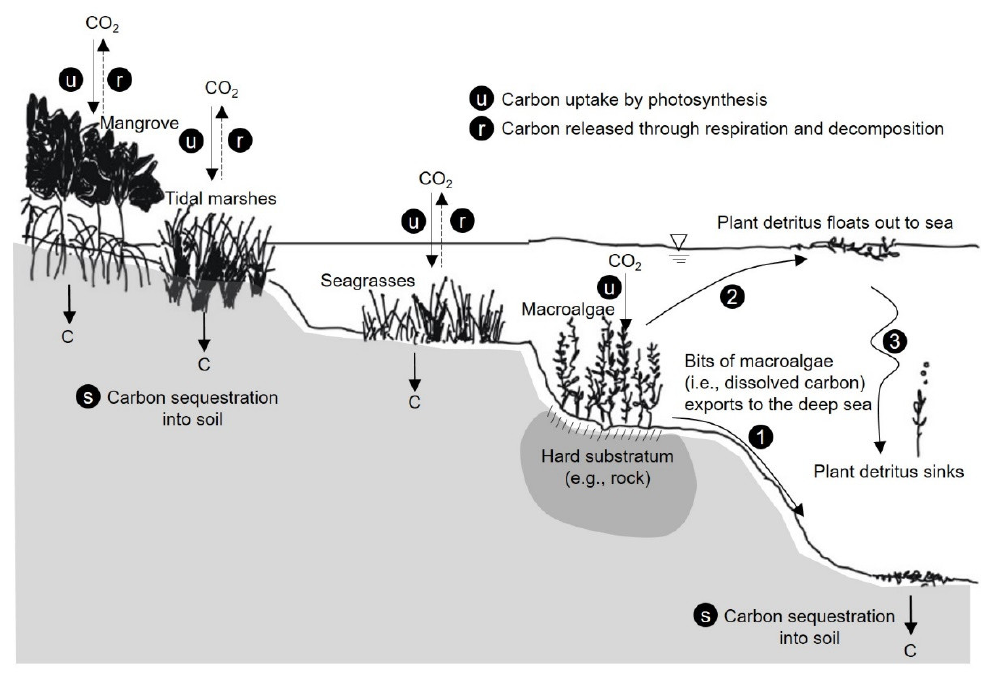
Figure 2. Carbon sequestration process by macroalgae and angiosperm-dominated ecosystems (e.g., mangroves, saltmarshes, and seagrasses). The angiosperm-dominated ecosystems uptake carbon by photosynthesis, release carbon through respiration and decomposition in the shore (often disturbed by natural and anthropogenic factors, e.g., runoff, human activity, and storms), and sequester the rest of the carbon into soil [21,23]. In contrast, macroalgae grow in a hard substratum (e.g., rock) where plant materials cannot be buried and where there is less disturbance by natural and anthropogenic factors; thus, they have less chance of releasing carbon to the atmosphere and sequestering carbon into the substratum. Instead, the carbon sequestered in macroalgae is sent to the deep sea either of the following ways [21]. First, bits of macroalgae in rocky and eroding conditions get exported to the deep sea, where the carbon can be sequestered. Second, using gas-filled bladders, macroalgae float towards the surface where they receive more sunlight for photosynthesis. Once the air bladders burst, the plant detritus sinks down towards the deep sea, where the carbon is likely to be sequestered away from the atmosphere for centuries and possibly up to millions of years